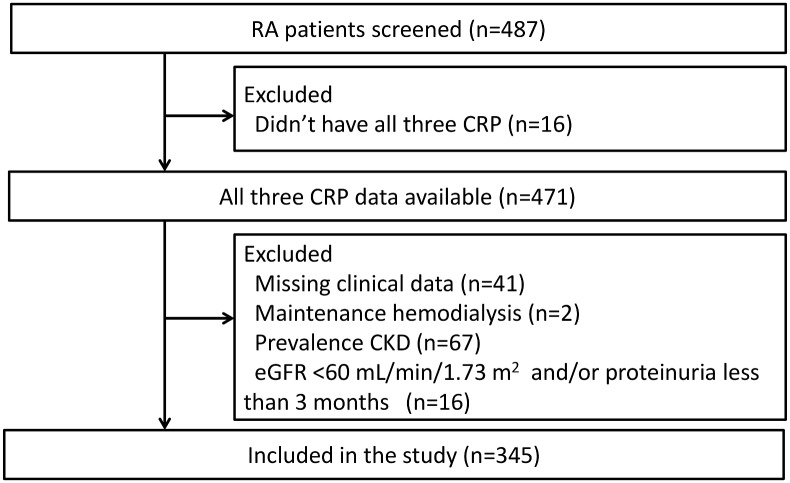
Flow chart of the study population.This chart indicates the selection of the study population and the exclusion strategy.